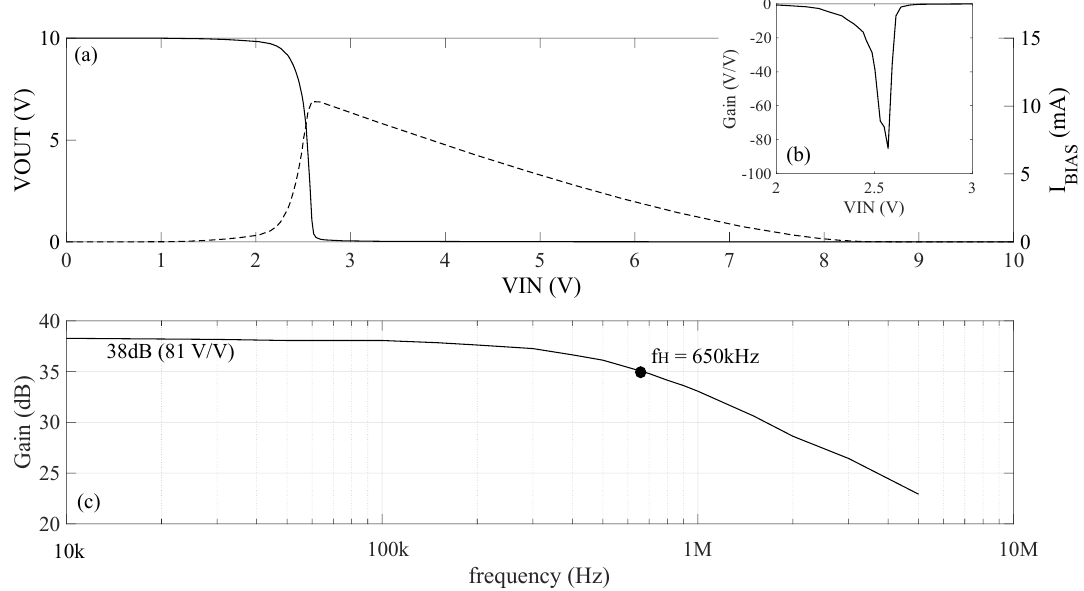
Figure 23. Performance of the LL-PFGA with 2N7000 as NMOS of the inverter. C IN = 100 nF, V B =